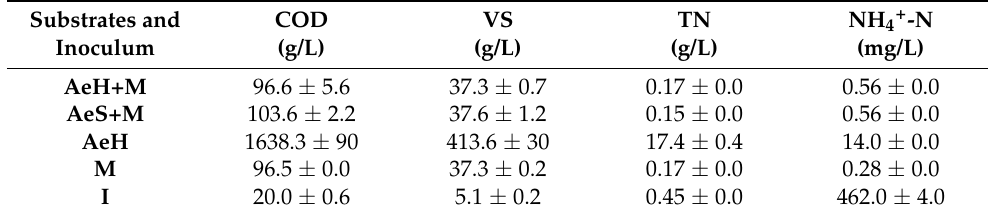
Table 1. Substrates and inoculum: chemical composition. Substrates and Inoculum